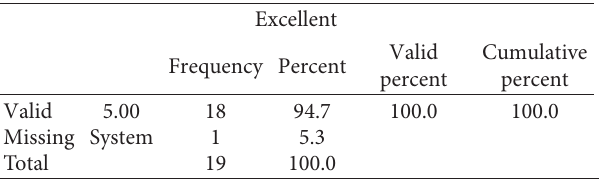
Table 3: The scale results illustrate an excellent assessment of the images view improvement by